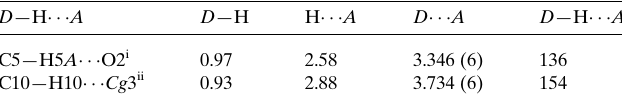
Table 1 Hydrogen-bond geometry (A˚ , (cid:2) ). Cg 3 is the centroid of the C7–C12 ring.